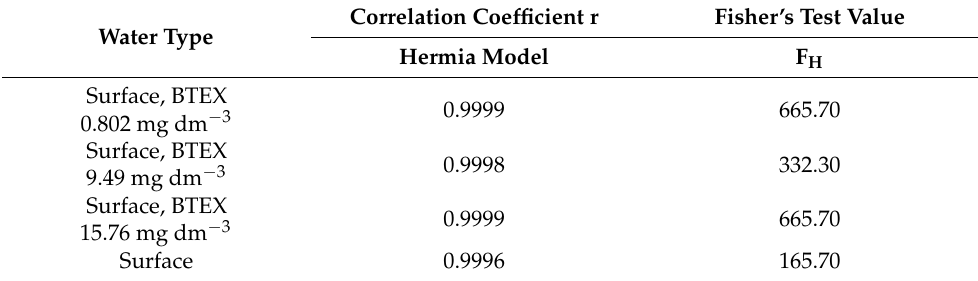
Table 5. Correlation coefficients obtained for the applied model relating to the experimental data and the obtained values of the significance level using the Fisher’s